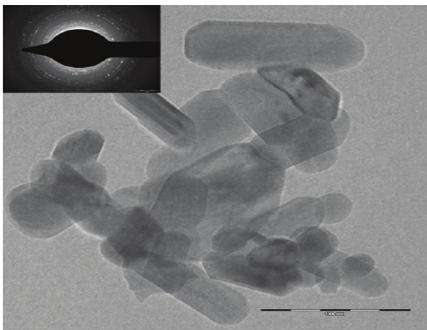
Figure 4: TEM image of as-prepared CaNb 2 O 6 nanopowder and its SAED pattern inset.